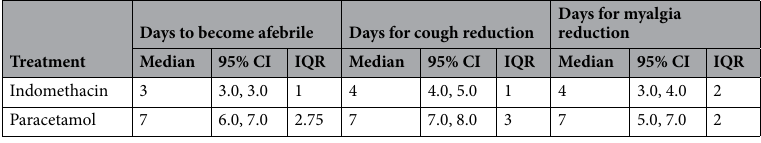
Table 3. Symptomatic relief due to various treatments.